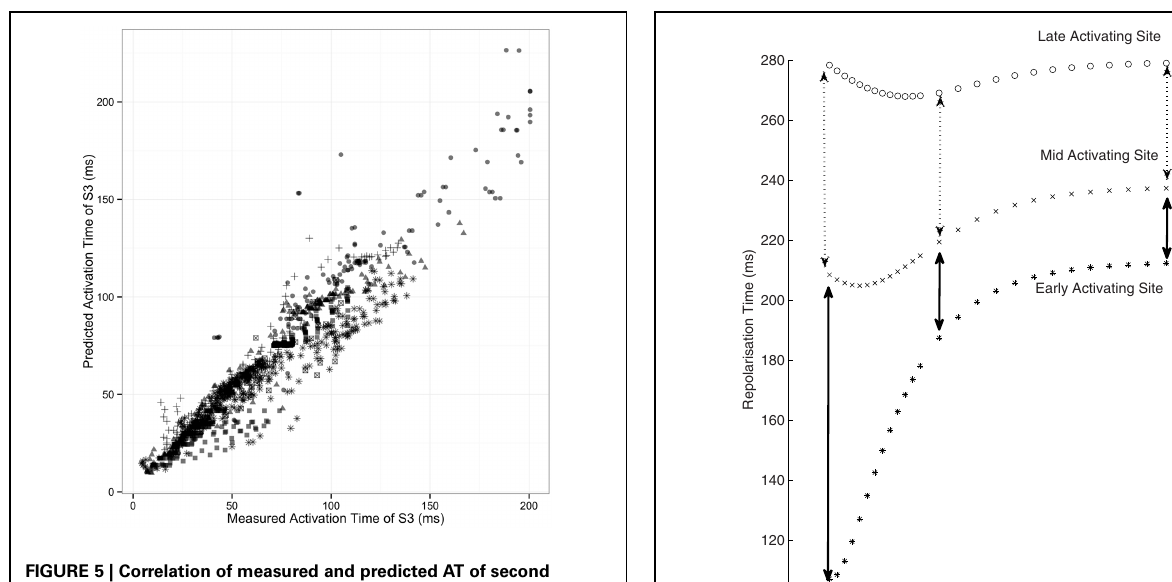
FIGURE 5 | Correlation of measured and predicted AT of second extrastimulus. The correlation of modeled S 3 activation time with measured S 3 activation is shown. Each patient is represented by individual symbols. r 2 = 0 . 90.